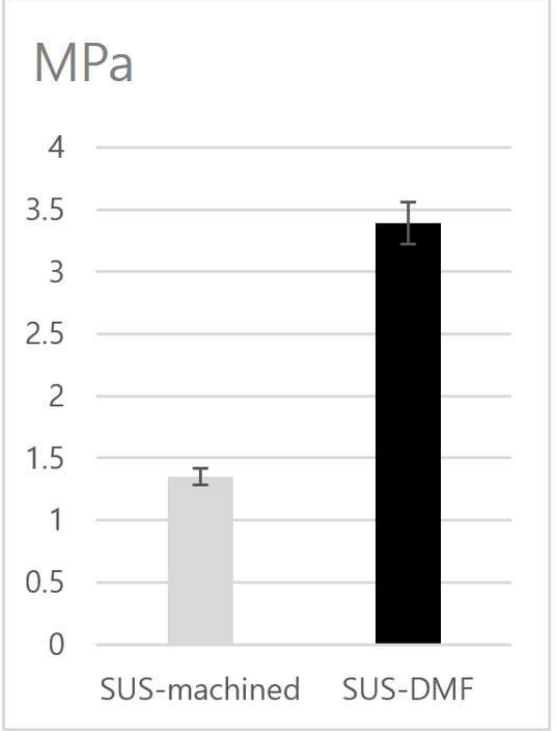
Figure 4. Results of the shear stress of the SUS-machined group and the SUS-DMF group in the push-out test.